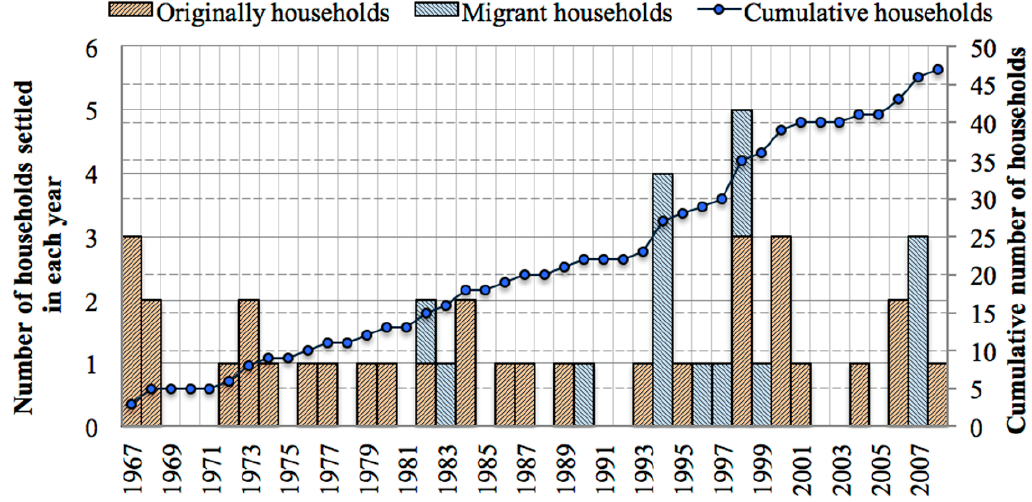
Figure 3. Sample household settlement in the study village.